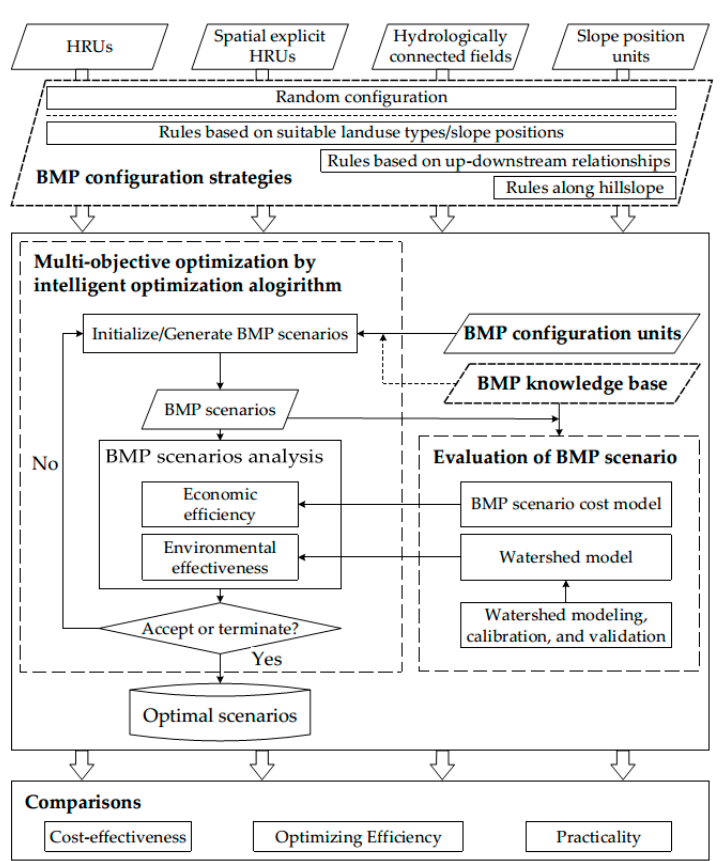
Figure 2. Framework comparing the effects of different BMP configuration units for the spatial optimization of watershed BMP scenarios in this study (extended from [2] ).